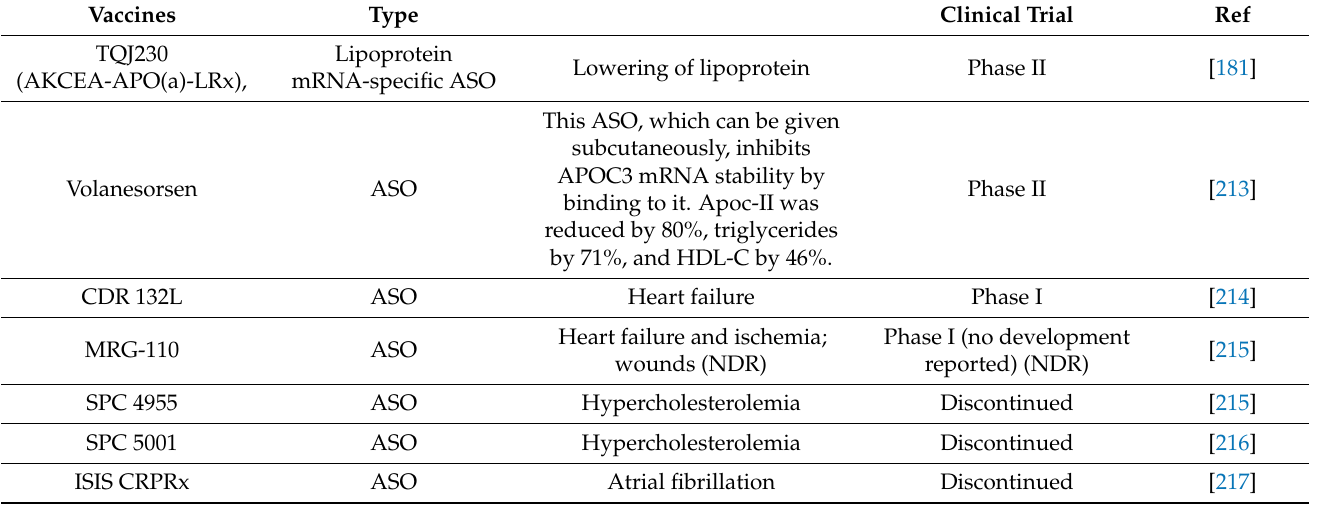
Table 3. Enlisted vaccines in clinical